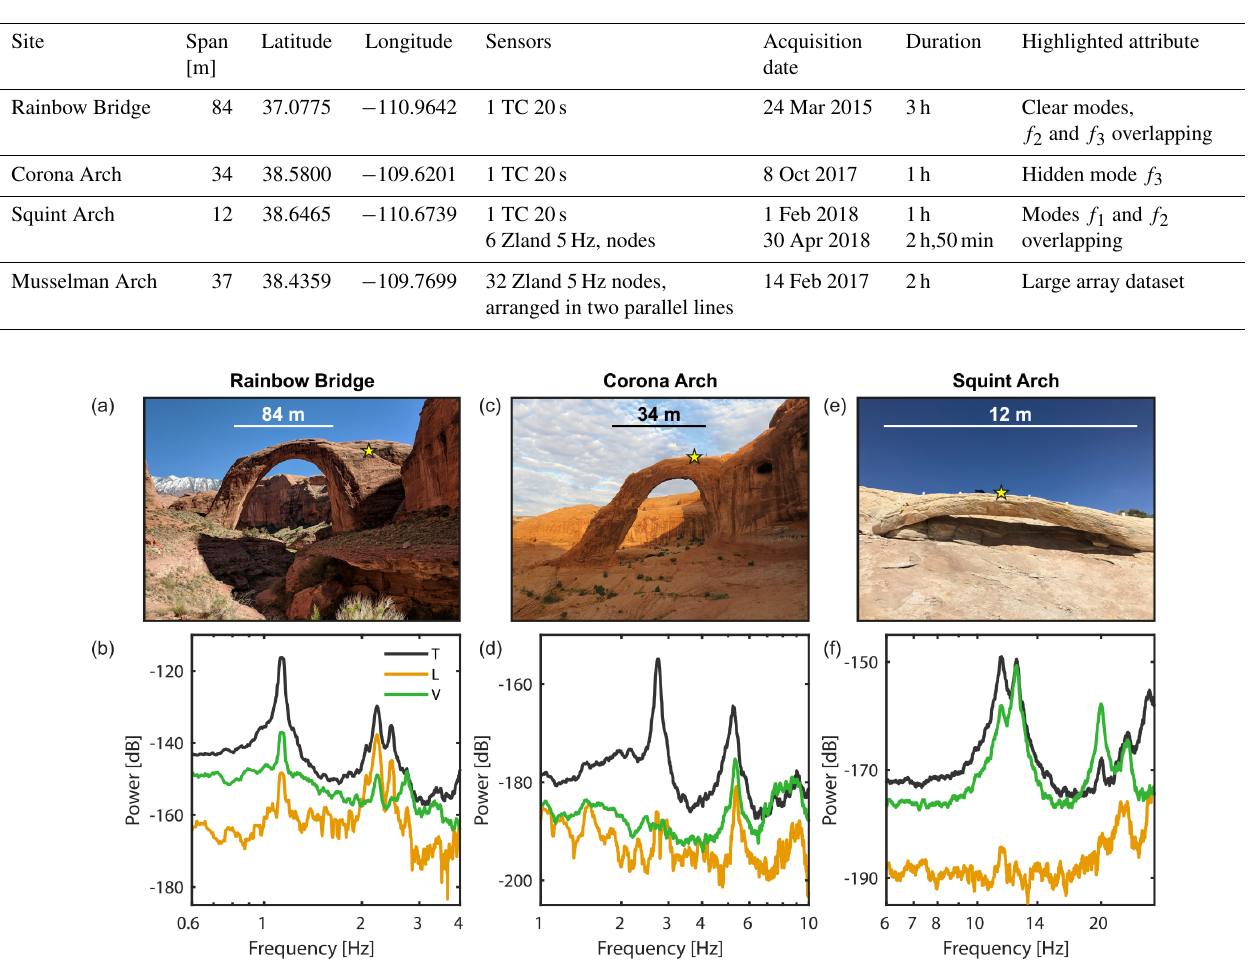
Figure 1. (a) Photograph of Rainbow Bridge with the sensor location marked by the yellow star. (b) Power spectra recorded at Rainbow Bridge. Components are oriented transverse to the arch span (T), longitudinal or parallel to the arch (L), and vertical (V). Relative power is given in decibel [dB] units of spectral velocity [m 2 s − 2 ]. ( c, d ) Photograph and power spectra of Corona Arch. ( e, f ) Photograph and power spectra of Squint Arch. Photographs in panels (a) and (c) are from Moore et al.